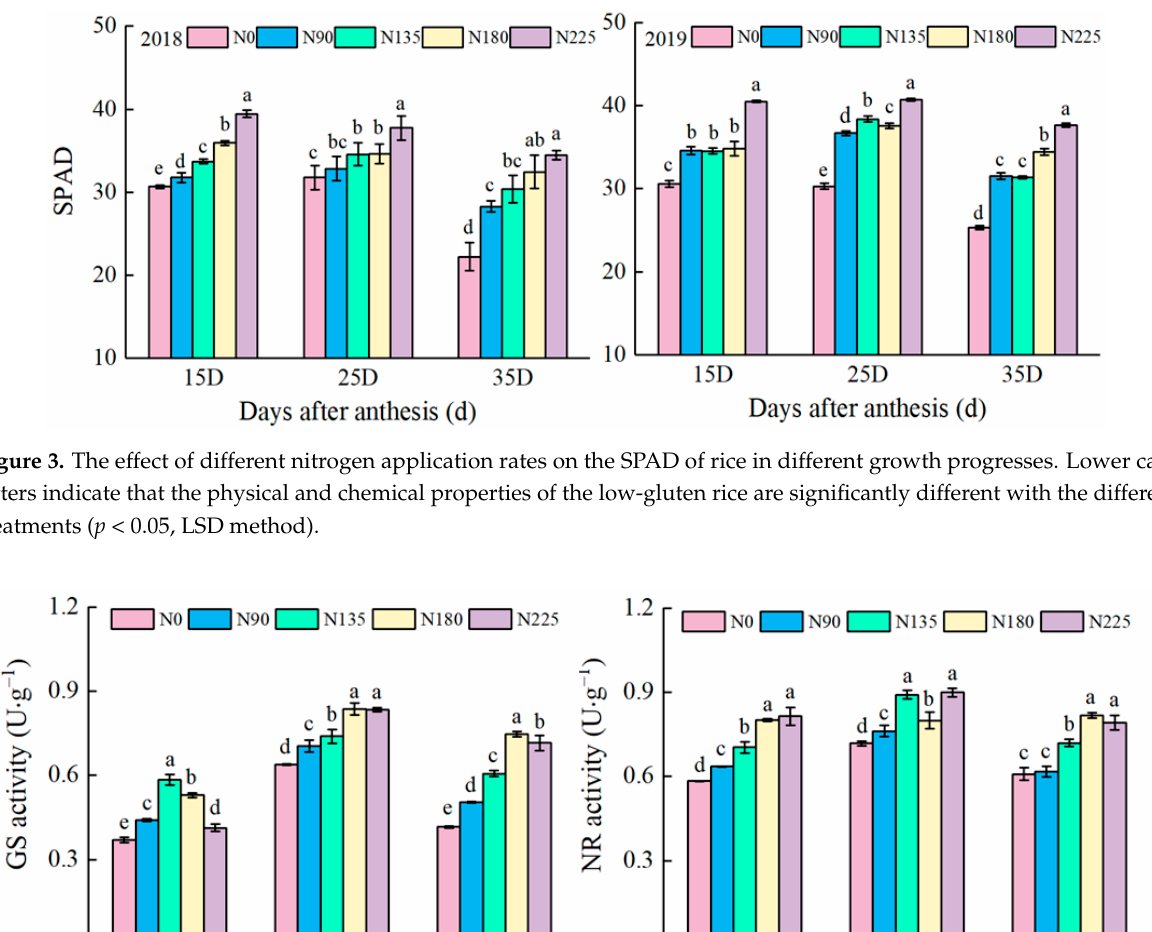
Figure 3. The effect of different nitrogen application rates on the SPAD of rice in different growth progresses. Lower case letters indicate that the physical and chemical properties of the low-gluten rice are significantly different with the dif- ferent treatments ( p < 0.05, LSD method).